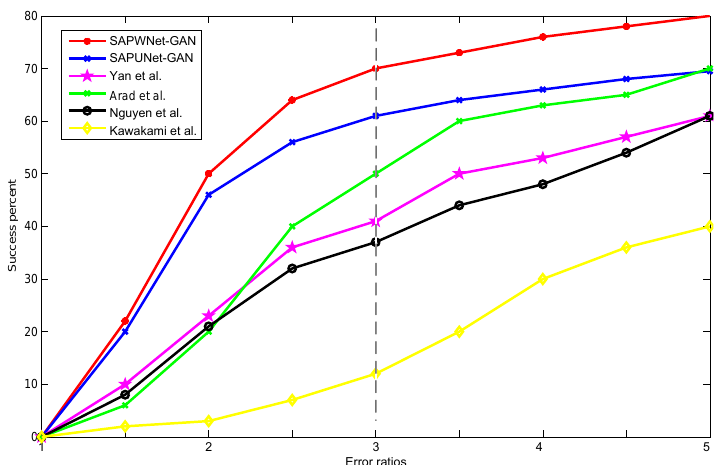
Figure 8. Quantitative evaluation on the Chakrabarti dataset in comparison with several state-of-the-art hyperspectral reconstructing methods: Yan et al. [16], Arad et al. [3], Nguyen et al. [14], Kawakami et al. [20].